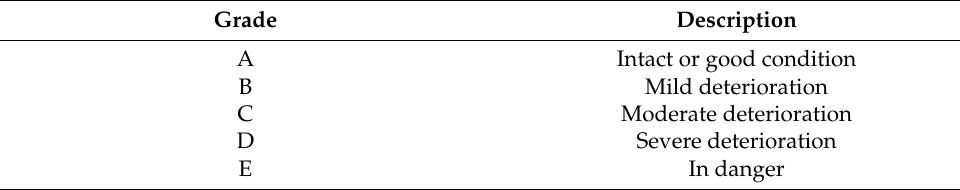
Table 2. Classification of bridge condition state.